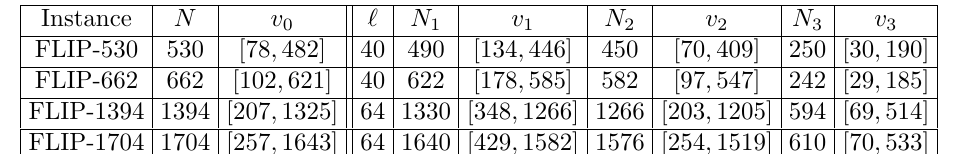
Table 2: Balancedness (with constant weight inputs) bias on FLIP filtering function instances, and modified instances. N is the number of variables of the instance, ‘ is the number of variables guessed to be 0. v i stands for the range of weights with bias < 2 − ‘ for the various strategies of guesses i and N i the number of variables of the resulting function, with v 0 the attack without guesses of the N variable function.